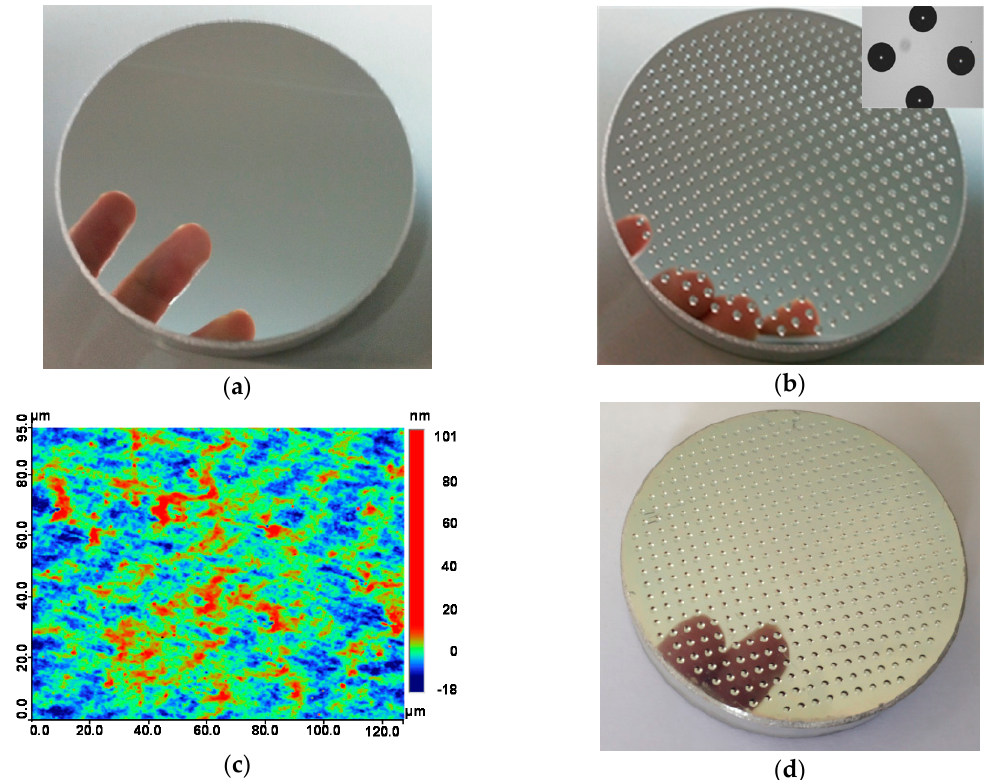
Figure 6. Different stages in the fabrication of the hybrid-structure microlens array (MLA) metal wafer mold: photographs of ( a ) the flat mirror surface obtained by diamond-turning and ( b ) the micromilled MLA mold cavities on the substrate and edge profile of the processed sample, ( c ) the MLA mold 3D surface finish of the lenslet apex region without nanostructures (Sa = 3.362 nm), and ( d ) the final MLA mold with antireflection nanostructures, which was fabricated using the anodic aluminum oxidation (AAO) process.